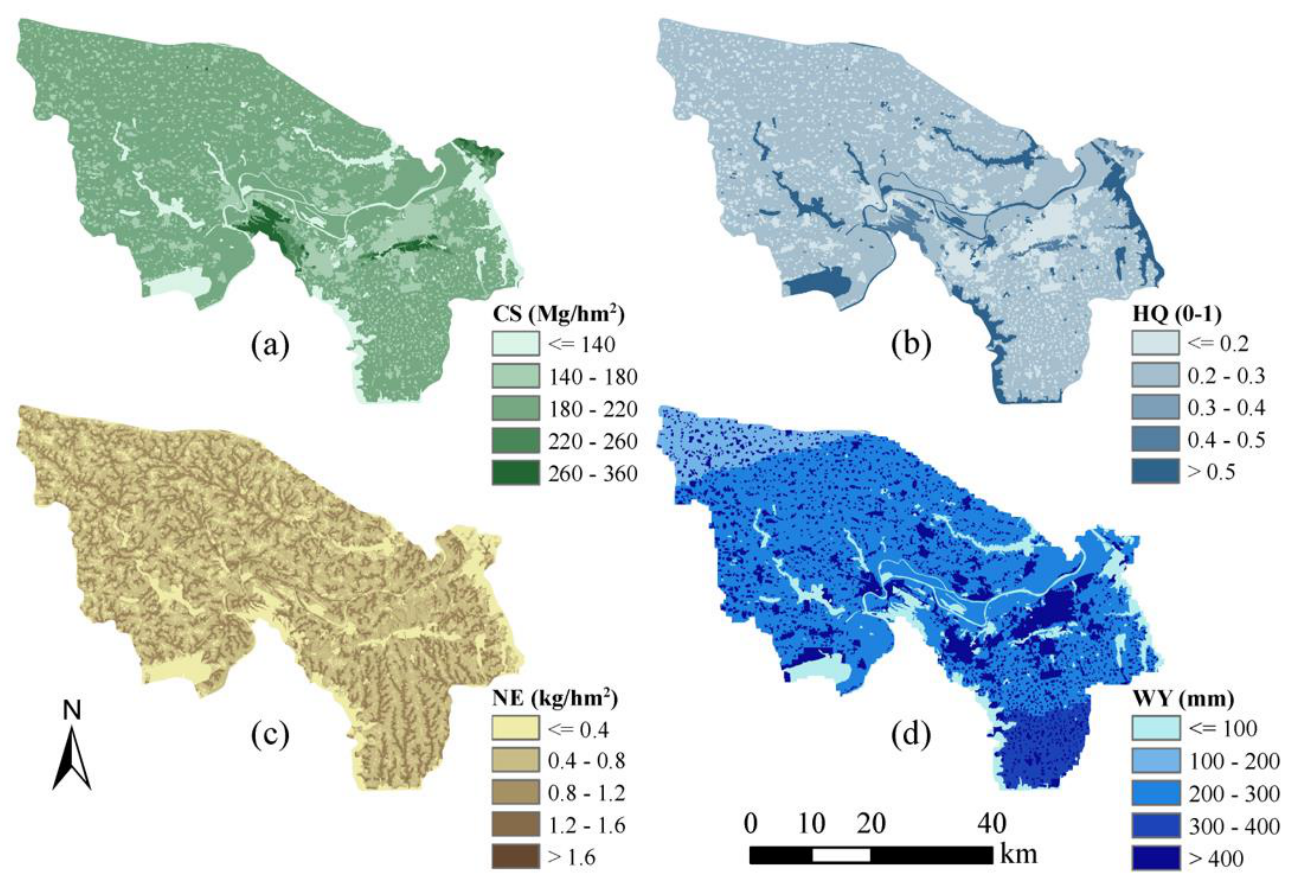
Figure 2. Spatial distribution of the four key ecosystem services in Huainan in 2020. ( a ) The spatial distribution of carbon storage (CS). ( b ) The spatial distribution of habitat quality (HQ). ( c ) The spatial distribution of nitrogen export (NE). ( d ) The spatial distribution of water yield (WY).